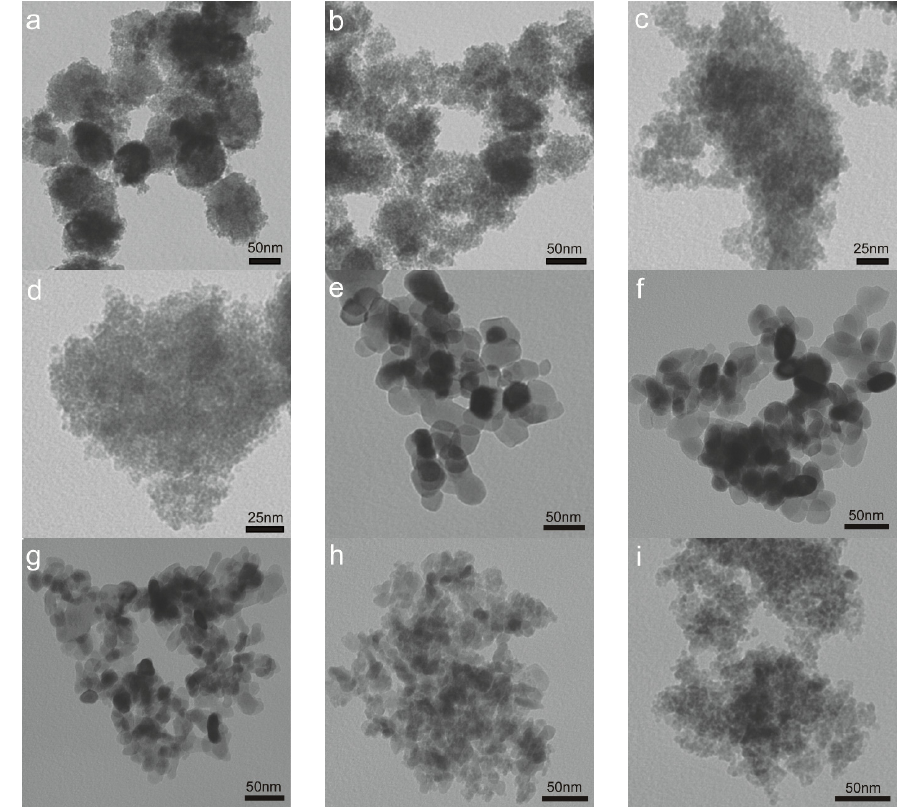
Figure 2. TEM images of fresh Au/FeO x catalysts: ( a ) Au/Fe_OH_11.2; ( b ) Au/Fe_OH_9.7; ( c ) Au/Fe_OH_8.2; ( d ) Au/Fe_OH_6.7; ( e ) Au/Fe_O_600; ( f ) Au/Fe_O_500; ( g ) Au/Fe_O_400; ( h ) Au/Fe_O_300; and ( i ) Au/Fe_OH_200.